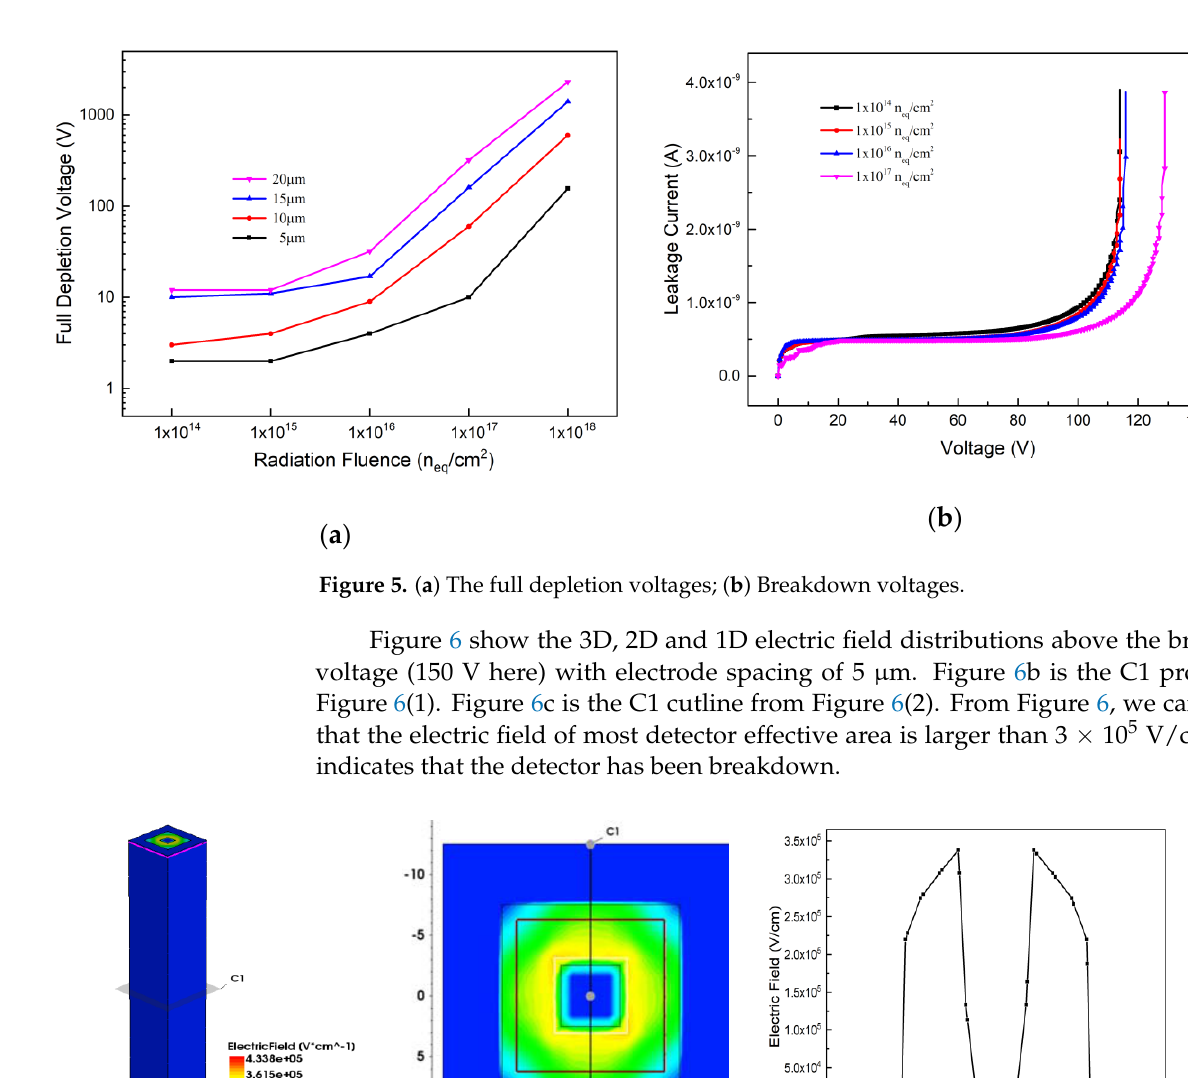
Figure 6. The electric field distribution of the device at the breakdown voltage; ( a ) 3D distribution; ( b ) 2D profile; ( c ) 1D cutline.